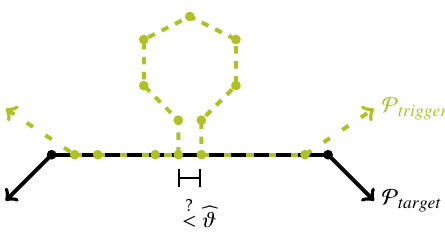
Figure 3. Projections of vertices form a